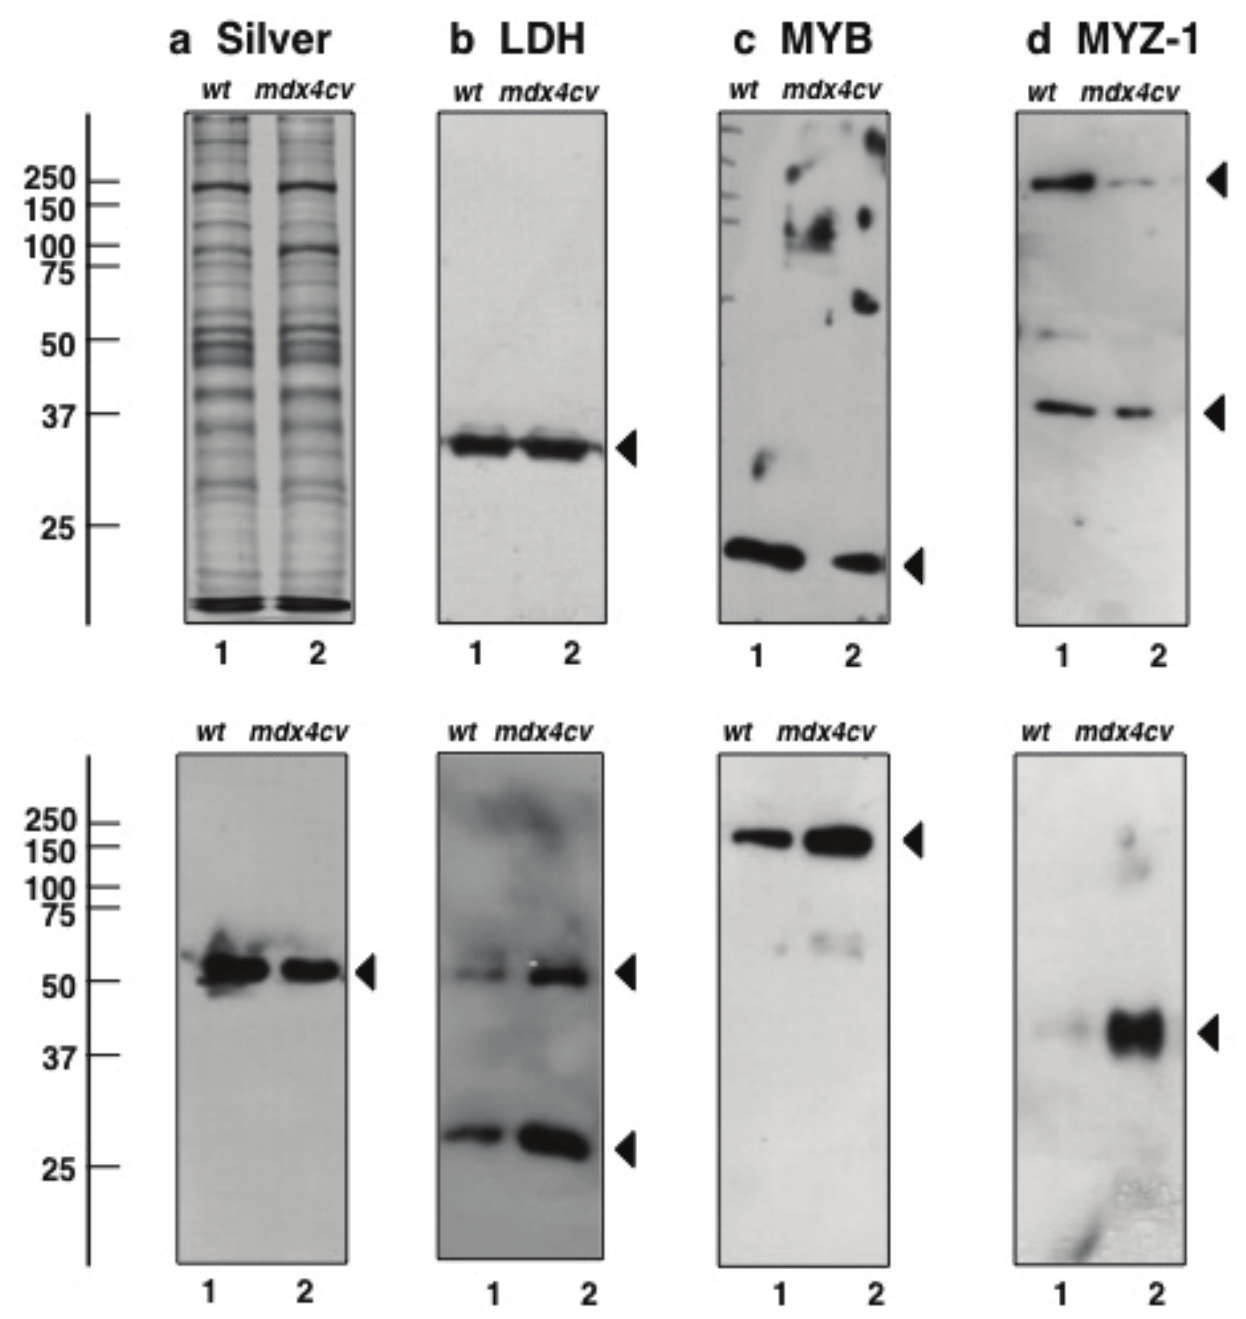
Figure 8. Immunoblot analysis of proteins with a considerable change in concentration levels in mdx-4cv skeletal muscle tissue. Shown is a silver-stained gel ( a ) and representative immunoblots ( b – h ). Lanes 1 and 2 represent crude microsomes from wild type muscle and dystrophic mdx-4cv muscle, respectively. Blots were labeled with antibodies to lactate dehydrogenase (LDH) ( b ), myoglobin (MYB) ( c ), myozenin (MYZ-1) ( d ), pyruvate dehydrogenase (PDH) ( e ), (cid:2)-tubulin ((cid:2)-TUB) (f), periostin (POSTN) ( g ) and vimentin (VIM) ( h ). The graphical representations of immuno-decoration levels are shown in supplementary Figure S3. Arrowheads indicate immuno-labelled bands. In the case of myozenin and tubulin, high-molecular-mass bands were detected besides the main isoforms, possibly representing larger protein